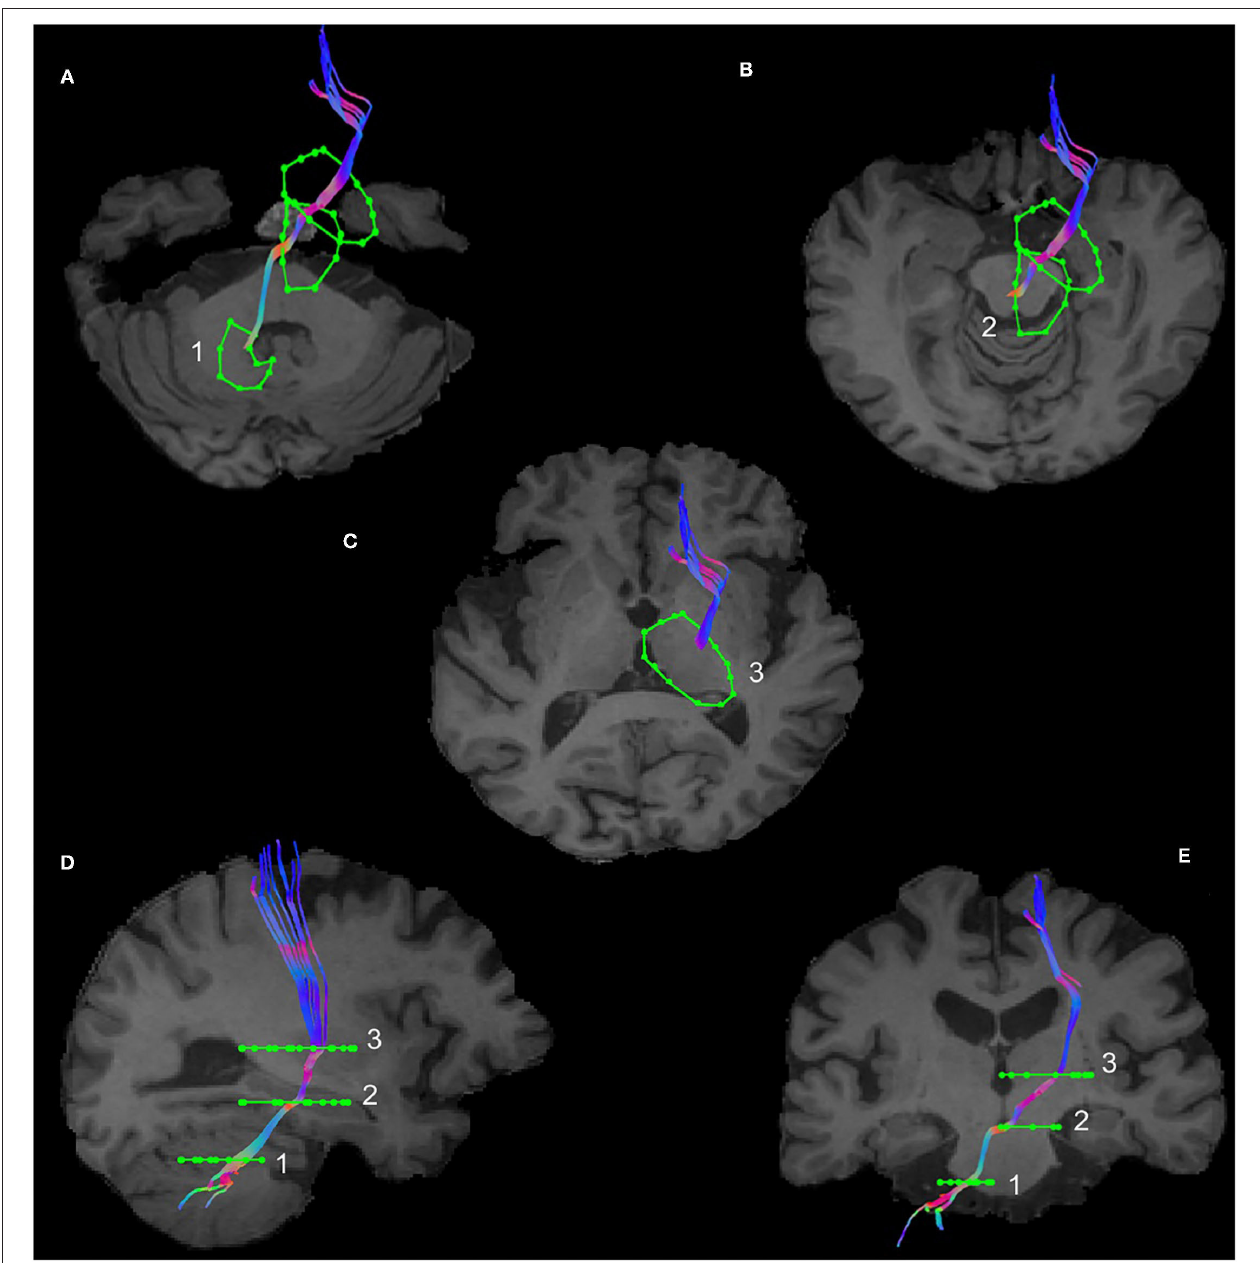
FIGURE 1 | The dentato-rubro-thalamic tract (DRTT) tract along with the regions of interest (ROIs) in axial, sagittal, and coronal views of T1 anatomical scan in an example data set. (A) Visualizes the DRTT tract from the dentate nucleus, (B) shows the DRTT decussating in the midbrain, and (C) shows the DRTT passing through the thalamus in the axial view. (D) Shows the entire DRTT with its cortical connections on a sagittal view and (E) shows the entire DRTT with its cortical connections on a coronal view. brain ( Figure 3A ) and a second ROI around the contralateral ( Figure 2 ). This procedure was repeated for the other hemisphere cerebellar hemisphere just below the pons was drawn also in the and for all the participants. For some datasets, the methods axial view of the brain as shown in Figures 3B,C . Appropriate described above were unsuccessful in delineating the SPCT or NOT ROIs for fiber exclusion were drawn to delineate the DRTT the DRTT due to difficulties in identifying the above described and the SPCT separately. A representative SPCT obtained using anatomical landmarks. If this was the case, a different approach this alternative method is shown in Figure 3D . The right and left was taken: an ROI was drawn around the thalamus covering the SPCTs are also shown in Supplementary Figure 2 posterior limb of the internal capsule in an axial view of the